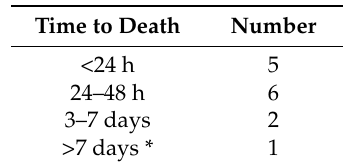
Table 6. Patient deaths related to air embolism.